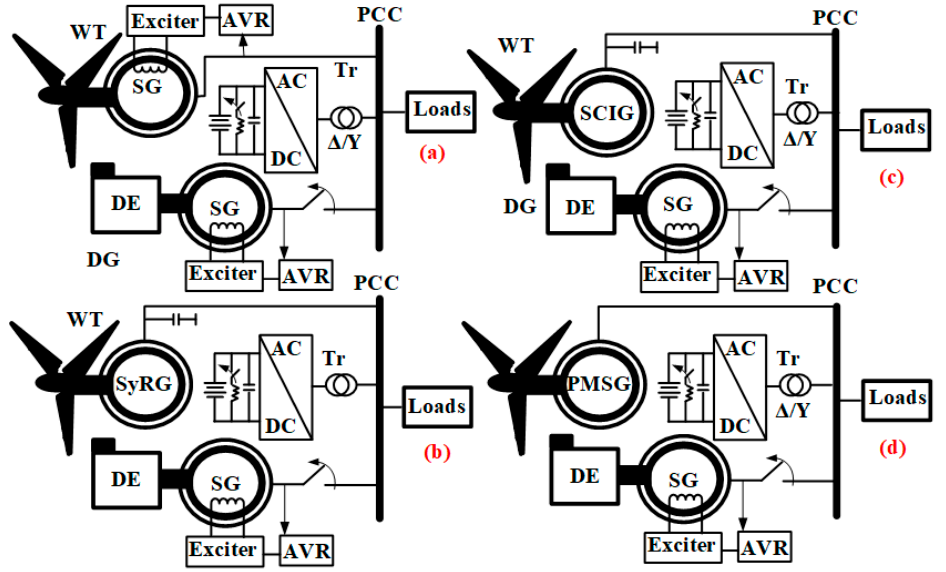
Figure 3. Off-grid configurations having DE driven SG and WT driven: ( a ) SG, ( b ) SyRG, ( c ) SCIG, and ( d ) PMSG.